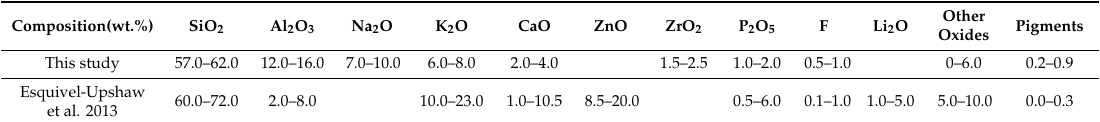
Table 3. Compositions of the disks from Ivoclar Vivadent scientific documentation for this study and another study